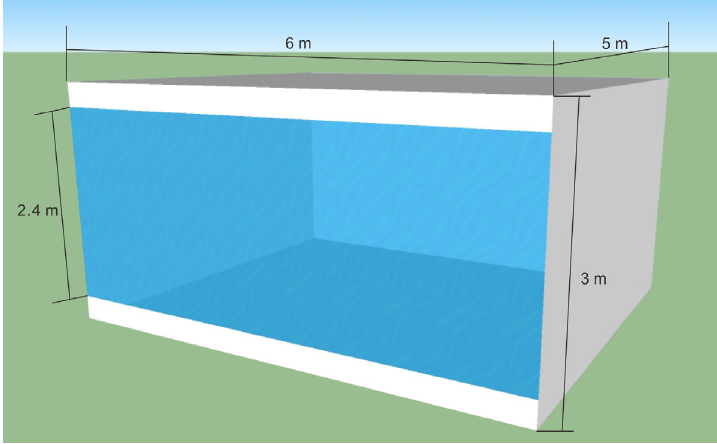
Figure 8. Model of typical glass curtain wall office space for